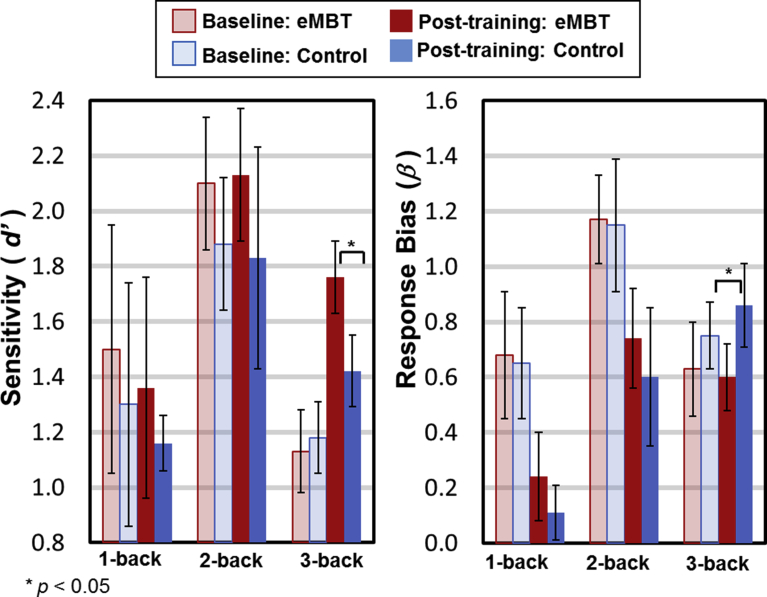
Mean, SE and statistical comparisons of signal detection measures of working memory performance within each group at baseline and post-training. Baseline data are represented by transparant fill and post-training data by solid fill both for the eMBT (red) and Control (blue) groups. For d′ scores, the higher values indicate a better ability to distinguish and detect target and non-target stimuli and thus an increase in signal discrimination. For response bias (β), a higher score indicates a more “cautious” response tendency (i.e., avoiding commission errors). A lower score indicates a more “free” response tendency to ensure a response is made to most or all targets.